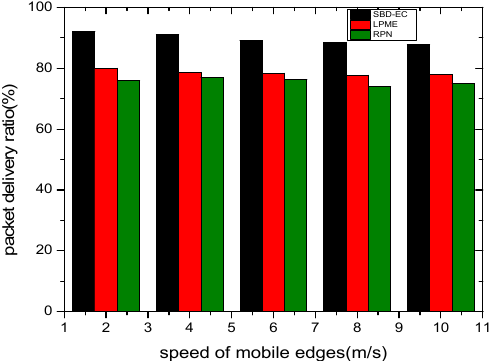
Figure 10. Delivery ratio and mobility.